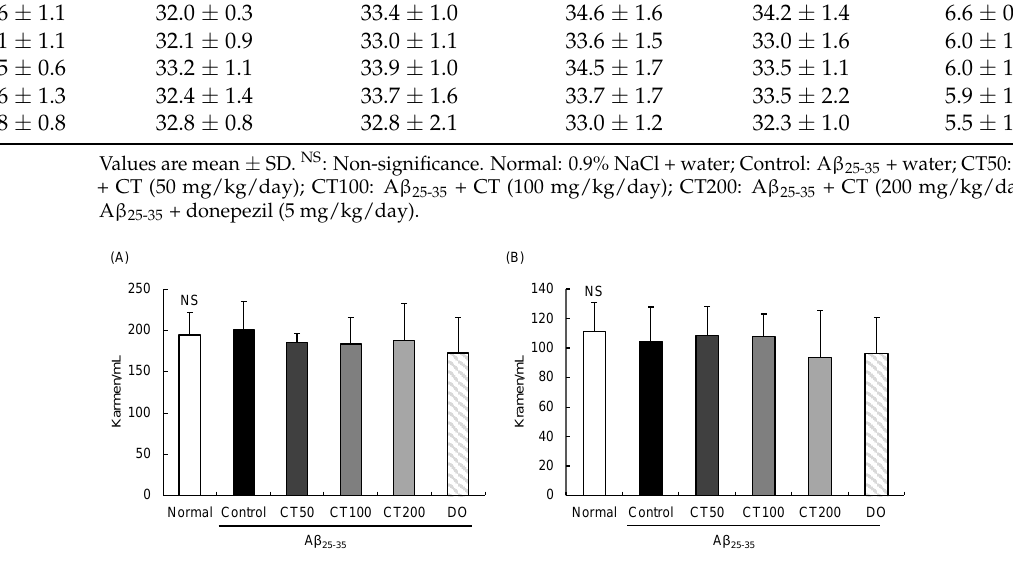
Figure 2. Effect of combination with Carthamus tinctorius L. seed and Taraxacum coreanum (CT) on AST ( A ) and ALT ( B ) in the serum of Aβ 25-35 injected mouse. Values are mean ± SD. NS: Non-significance. Normal: 0.9% NaCl + water; Control: Aβ 25-35 + water; CT50: Aβ 25-35 + CT (50 mg/kg/day); CT100: Aβ 25-35 + CT (100 mg/kg/day); CT200: Aβ 25-35 + CT (200 mg/kg/day); DO: Aβ 25-35 + donepezil (5 mg/kg/day).